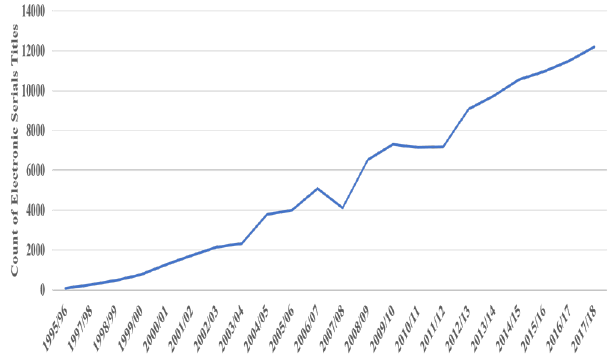
This shift of data print to digital was also indicated by the increase in the number of electronic serials titles reaching over 12,000 by